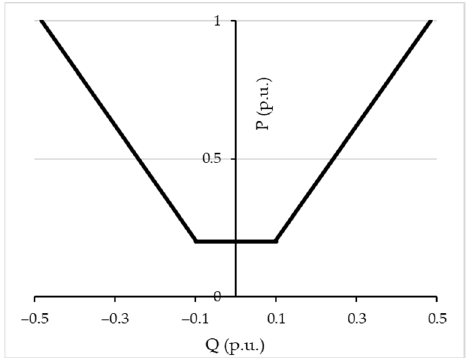
Figure 4. Capability curve assumed for DG in the voltage regulation framework.